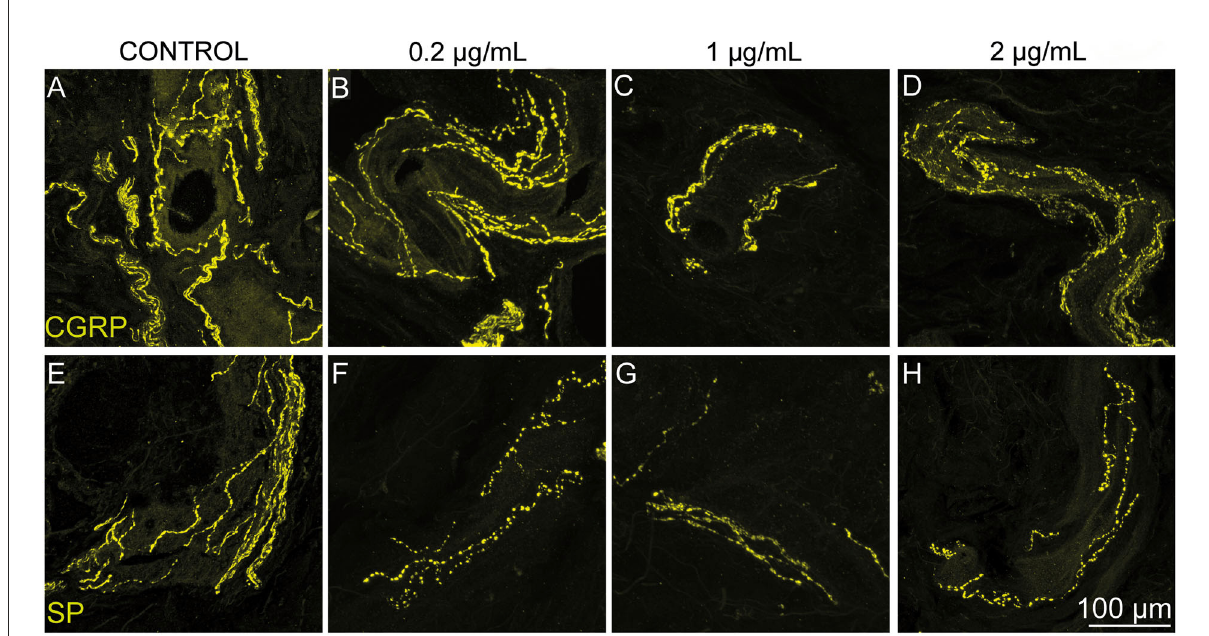
FIGURE2 Intravesical RTX treatment appeared to decrease the density of both CGRP- and SP-immunoreactive axons innervating the body of the urinary bladder of healthy adult sexually intact female cats. Representative confocal images showing CGRP (B–D) and SP (F–H) axons innervating the bladder body after administration of saline (control A, E ; n = 1) 0.2 ( B, F ; n = 2), 1 ( C, G ; n = 2), and 2 ( D, H ; n = 2) µ g/mL of RTX. An apparent reduction in the density of both markers was seen in cats treated with RTX (14 days post-treatment) when compared to the control (saline) animal (A, E) . Confocal images were obtained at 40 × magnification using a Carl Zeiss scanning confocal laser microscope with Z-stack